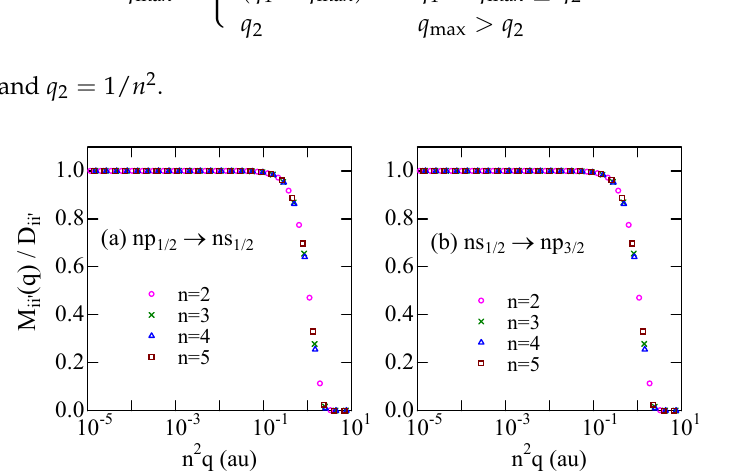
( q ) / D for the ( a ) np 1/2 → ns 1/2 and ( b ) ns 1/2 → np 3/2 transitions as ii (cid:48) ii (cid:48)